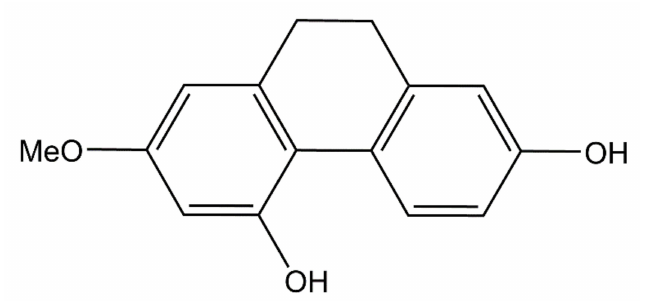
Figure 6. Structure of